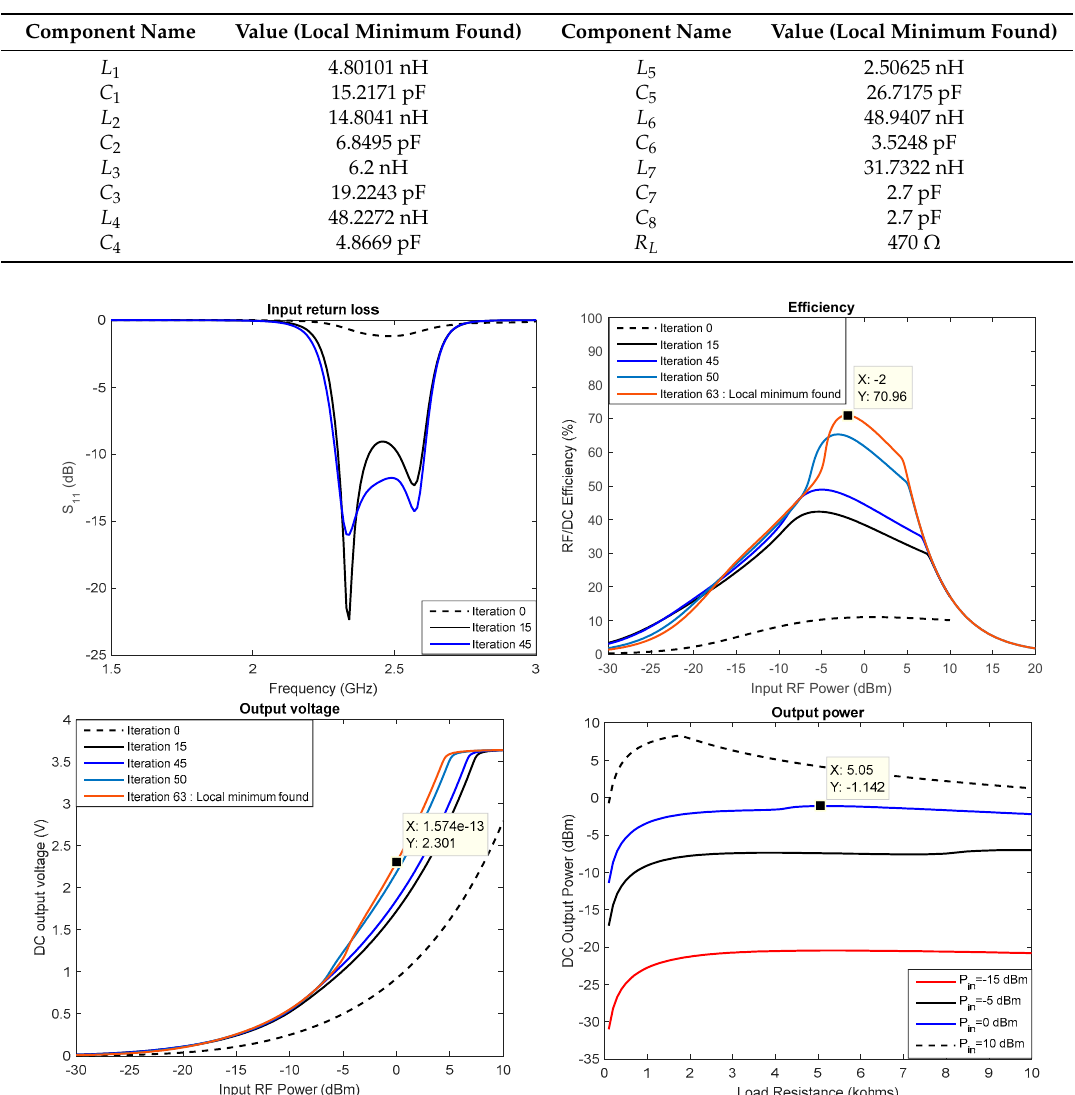
Figure 19. Optimized rectifier performance (simulated results).